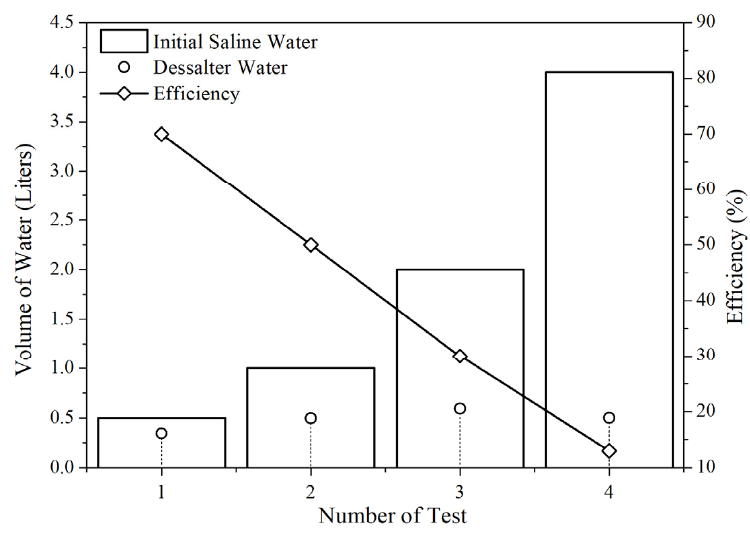
Figure 5. Desalinated water production and